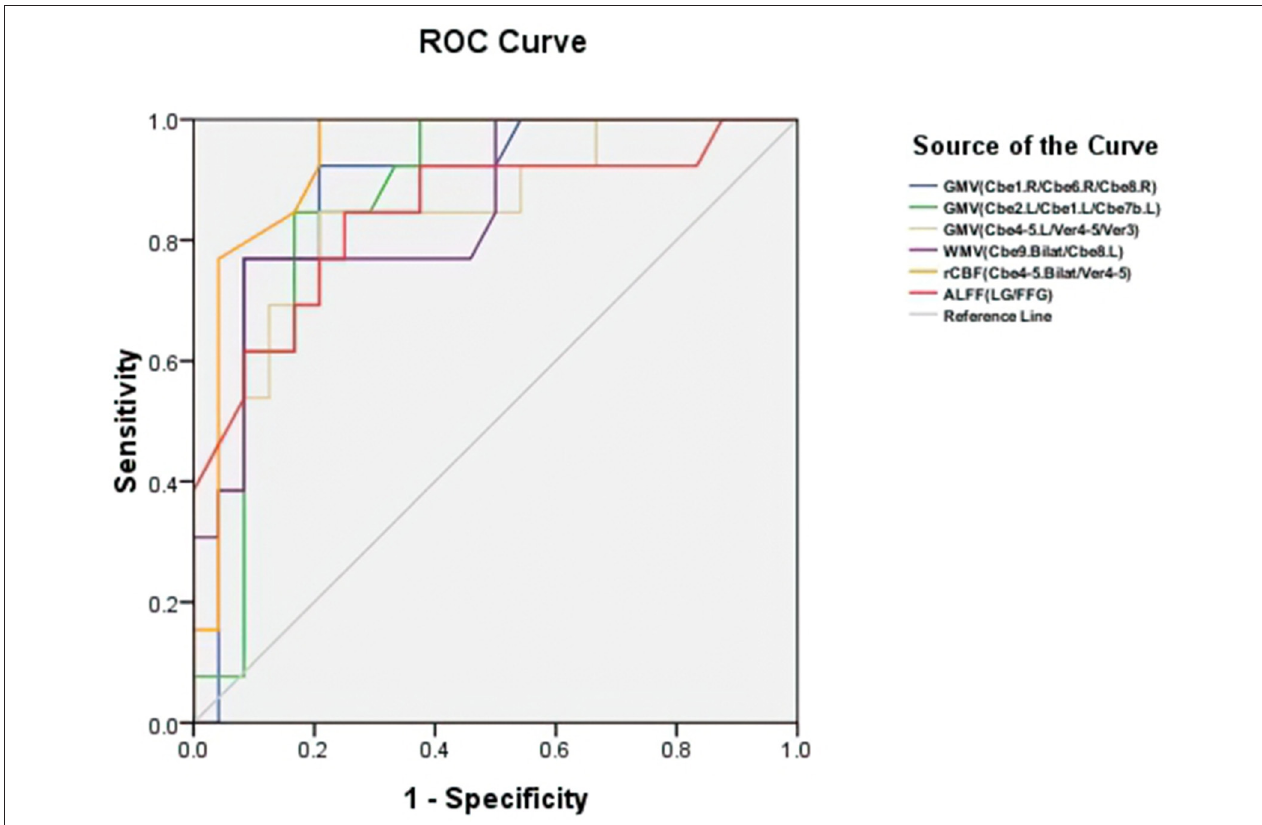
FIGURE 5 | Receiver operating characteristic (ROC) curve for structure, rCBF, and functional alterations in patients with MSA-c and MSA-p. The two groups can be differentiated with a sensitivity of 100% and specificity of 79.2% by using the rCBF values in cerebellum subregions (bilateral cerebellum_4_5) and vermis_4_5, the area under the curve (AUC) of rCBF biomarker was 0.936. By using the GM volume changes in cerebellum and vermis subregions (right cerebellum_1/ cerebellum_6/cerebellum_8, left cerebellum_2/cerebellum_1/cerebellum_7b, and left cerebellum_4_5/vermis_4_5/vermis_3), sensitivities reached 92.3%/84.6%/84.6% and specificities reached 79.2%/83.3%/79.2%, the AUC was 0.880/0.864/0.833, respectively. By using the WM volume changes in bilateral cerebellum_9/ left cerebellum_8, sensitivity reached 76.9% and specificity reached 91.7%, the AUC was 0.851. By using the functional change in right LG/FFG, sensitivity reached 84.6% and specificity reached 75%. The AUC of the function biomarker was 0.845. GMV, gray matter volume; WMV, white matter volume; rCBF, regional cerebral blood flow; ALFF, amplitude of low-frequency fluctuations; L, left; R, right; Bilat, bilateral; Cbe, cerebellum; Ver, vermis; LG, lingual gyrus; FFG,